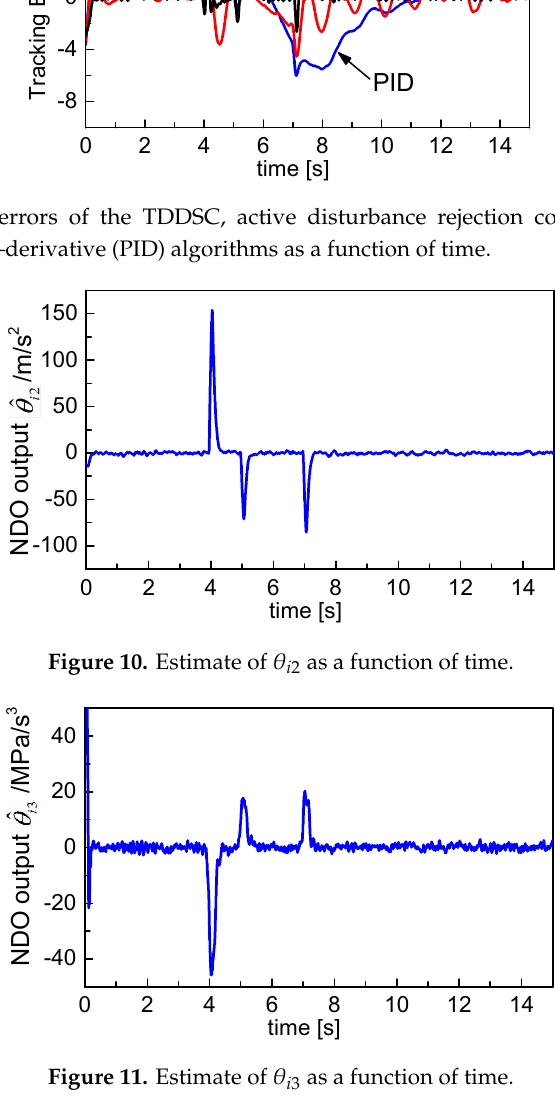
θ as a function of time. Figure 11. Estimate of θ i 3 as a function of Figure 11. Estimate of 3 i